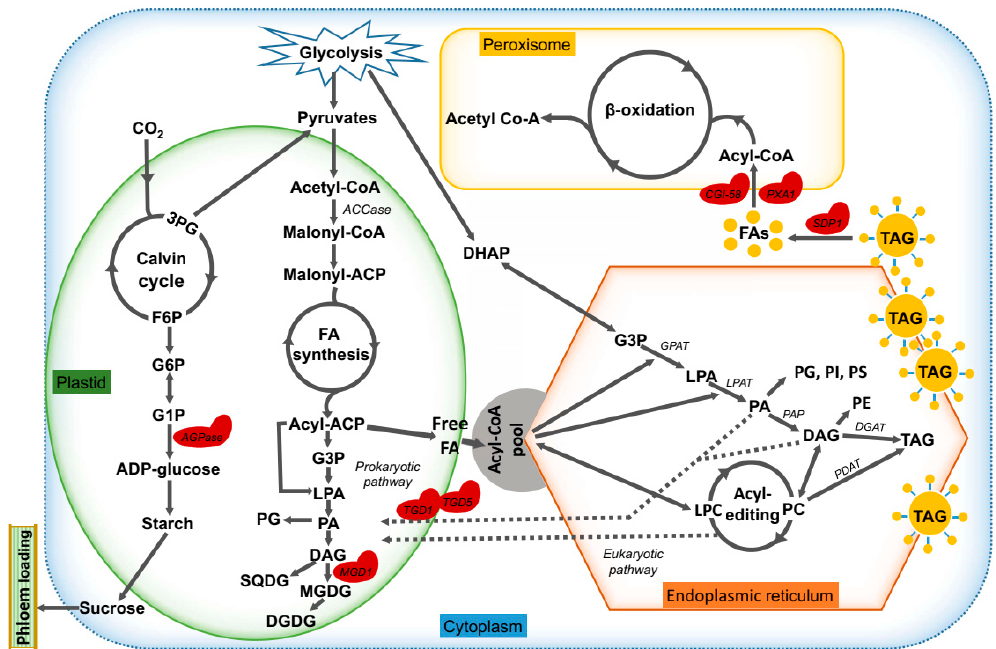
Figure 2 . Simplified diagrammatic representation of lipid biosynthesis in the photosynthetic tissues of plants. Prokaryotic and eukaryotic pathways for the synthesis of lipids in photosynthetic tissues are indicated within the plastid and endoplasmic reticulum, respectively. Enzymes that have previ- ously been reported to enhance foliar lipid content when their corresponding genes are knocked- down or knocked-out are indicated on a red background. Known reactions are denoted by solid gray lines, whereas putative events are denoted with dashed lines. Abbreviations: 3PG, 3-phospho- glycerate; ACCase, acetylCoA carboxylase; Acyl-ACP, acyl carrier protein; ADP-glucose, adenosine diphosphate glucose; AGPase, adenosine diphosphate glucose pyrophosphorylase; CGI-58, com- parative gene identification-58; CO 2 , carbon dioxide; DAG, diacylglycerol; DGAT, diacylglycerol acyltransferase; DGDG, digalactosyldiacylglycerol; DHAP, dihydroxyacetone phosphate; F6P, fruc- tose-6-phosphate; FAs, fatty acids; G1P, glucose-1-phosphate; G3P, glyceraldehyde 3-phosphate; G6P, glucose-6-phosphate; GPAT, glycerol-3-phosphate acyltransferase; LPA, lysophosphatidic acid; LPAT, lysophosphatidic acid acyltransferase; LPC, lysophosphatidylcholine; Malonyl-ACP, malonyl acyl carrier protein; MGD1, monogalactosyldiacylglycerol synthase 1; MGDG, monogalac- tosyldiacylglycerol; PA, phosphatidic acid; PAP, phosphatidic acid phosphatase; PC, phosphatidyl- choline; PDAT, phospholipid:diacylglycerol acyltransferase; PG, phosphatidylglycerol; PXA1, pe- roxisomal ABC-transporter; SDP1, sugar-dependent 1; SQDG, sulfoguinovosyldiacylglycerol; TAG, triacylglycerol; TGD1/5, trigalactosyldiacylglycerol 1/5.